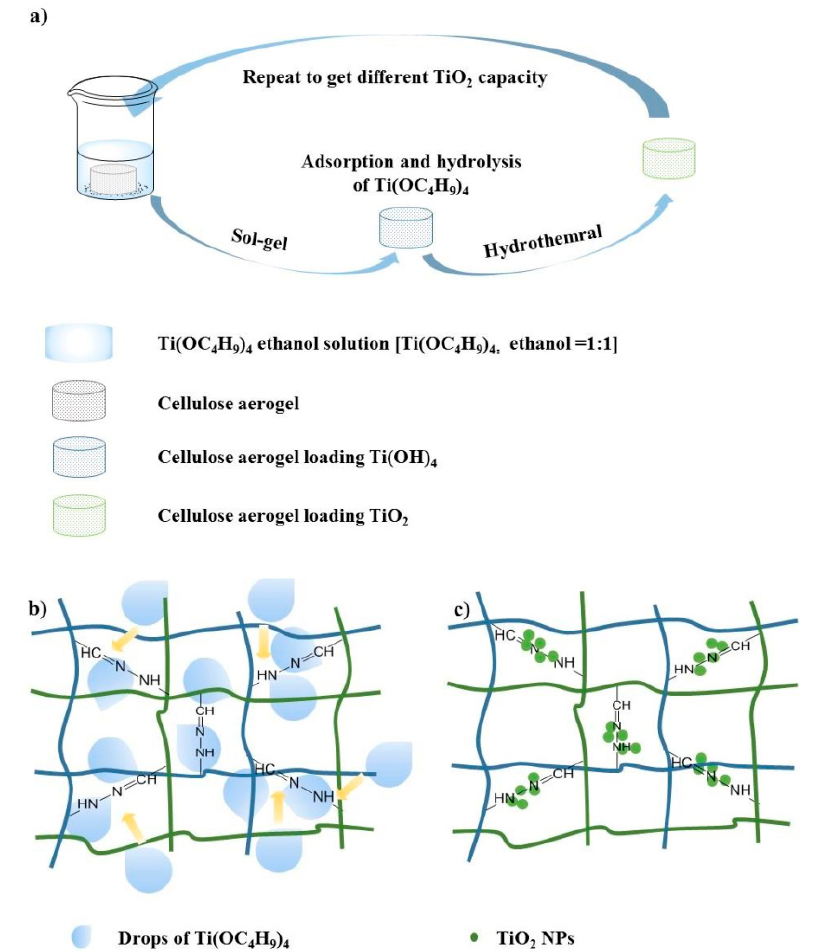
Figure 8. Schematic illustration of the TiO 2 loading process: ( a ) The overall preparation process of TiO 2 @CNF Aerogel, ( b ) Ti(OC 4 H 9 ) 4 was attracted by the polar groups of CNF Aerogel, and ( c ) TiO 2 NPs loaded on the crosslinking part of CNF Aerogel.